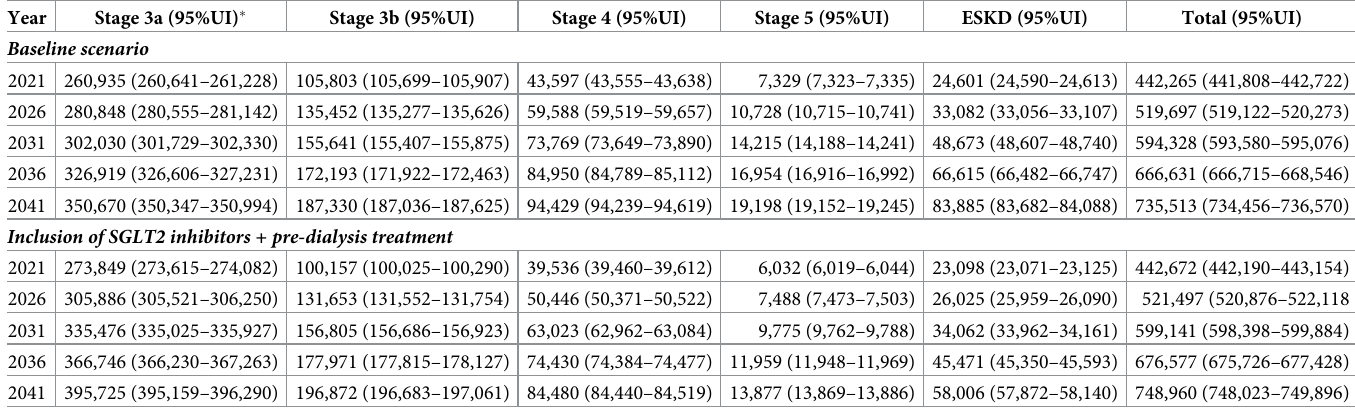
Table 3. Projection of the future number of Chilean adults with CKD by stage for years